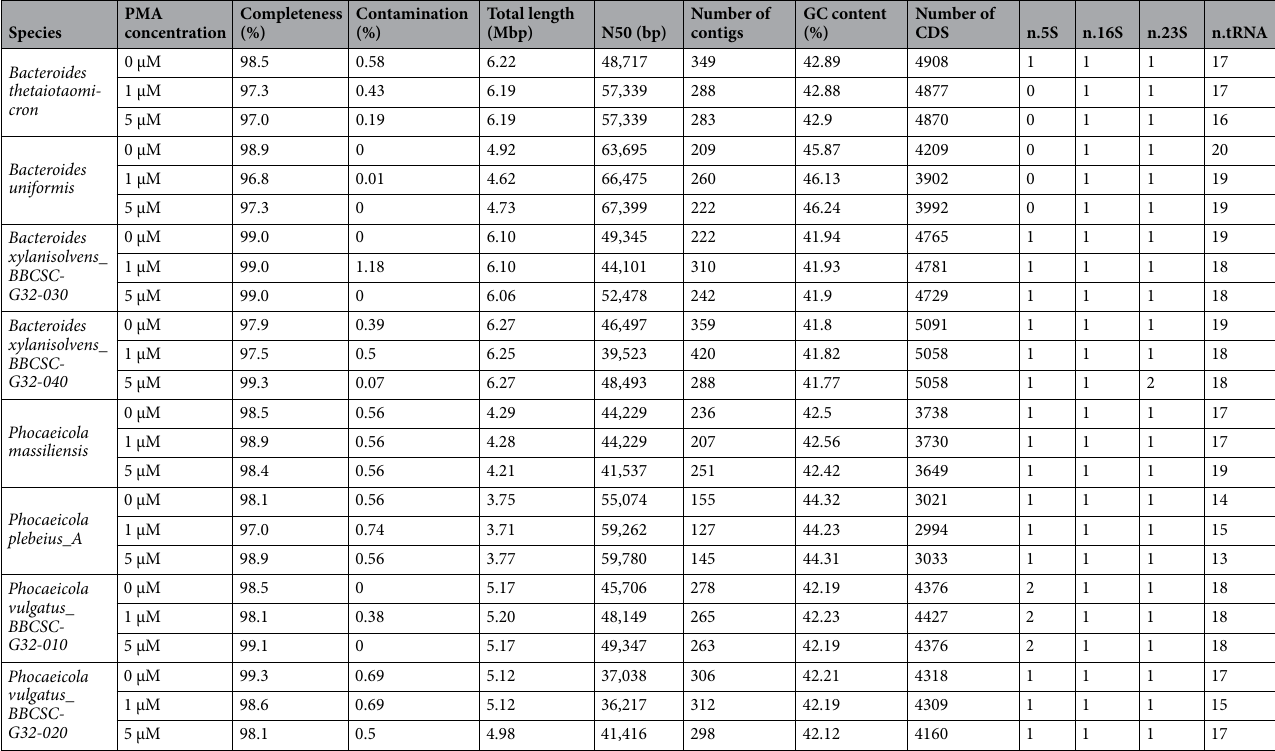
Table 1. Statistics of the composite single-amplified genome (SAG) of Bacteroidaceae